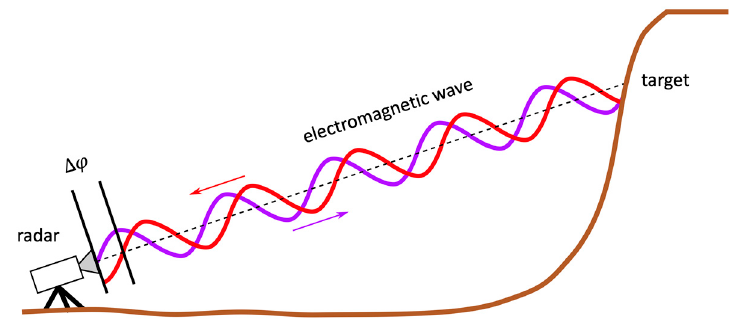
Figure 2. Working principle of ground based/terrestrial radar interferometry.